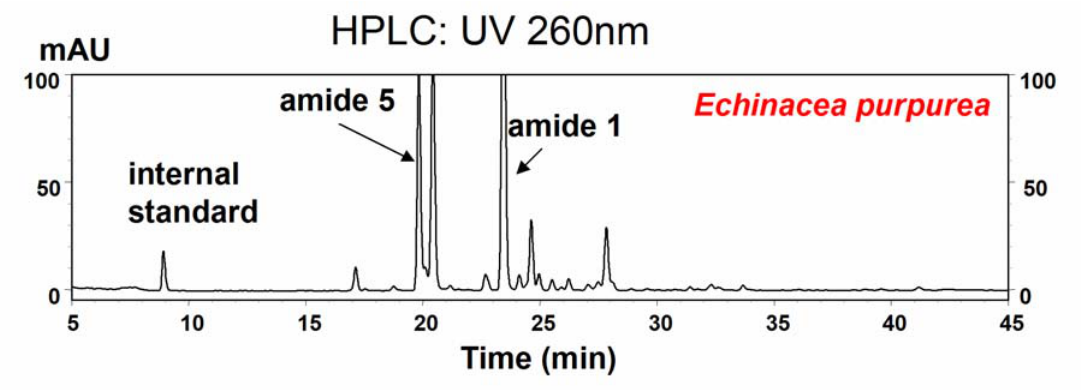
Figure 1. Representative HPLC chromatogram obtained from a 95% ethanolic extract of 6-month-old E. purpurea roots, indicating amides 1 and 5